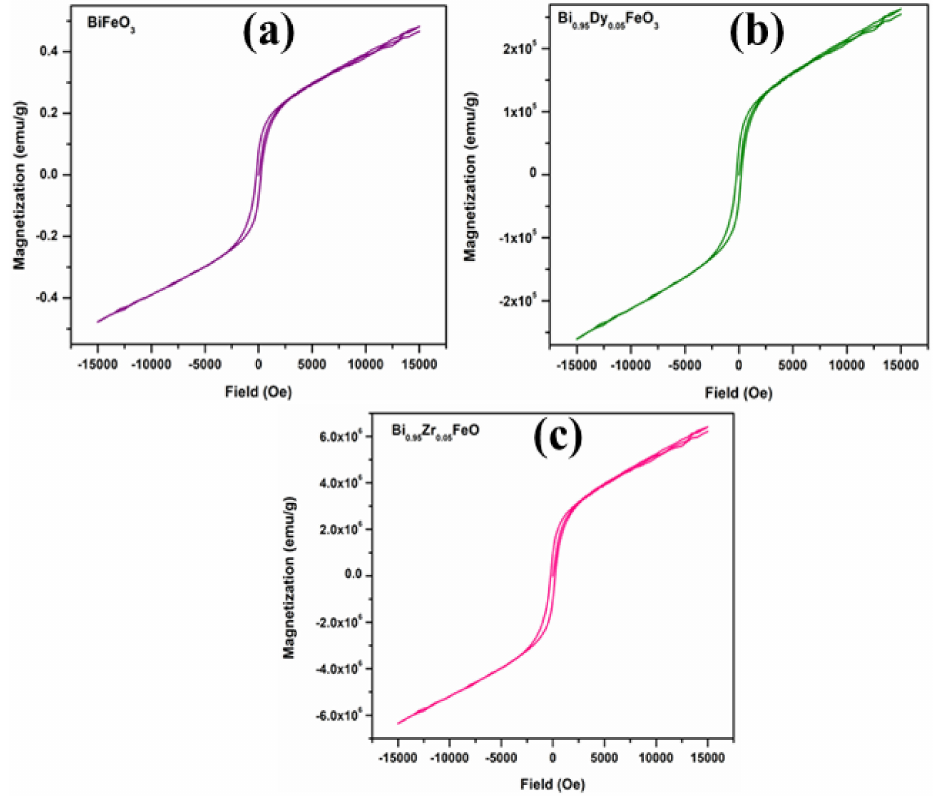
Table 2. Magnetic properties of BFO, BDFO, and BZFO thin films.